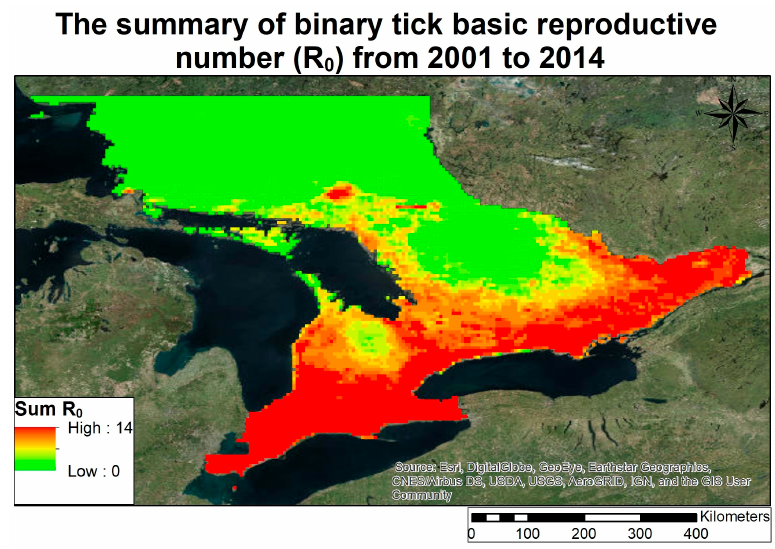
Figure 3. Summed basic reproductive number for tick populations in southern Ontario from 2001 to 2014. The values were reclassified as binary, with 1 for sustainable and 0 for unsustainable. A value of 14 indicates that a region was sustainable throughout the entire study period. A value between 1 and 13 inclusive indicates that a region became sustainable during the study